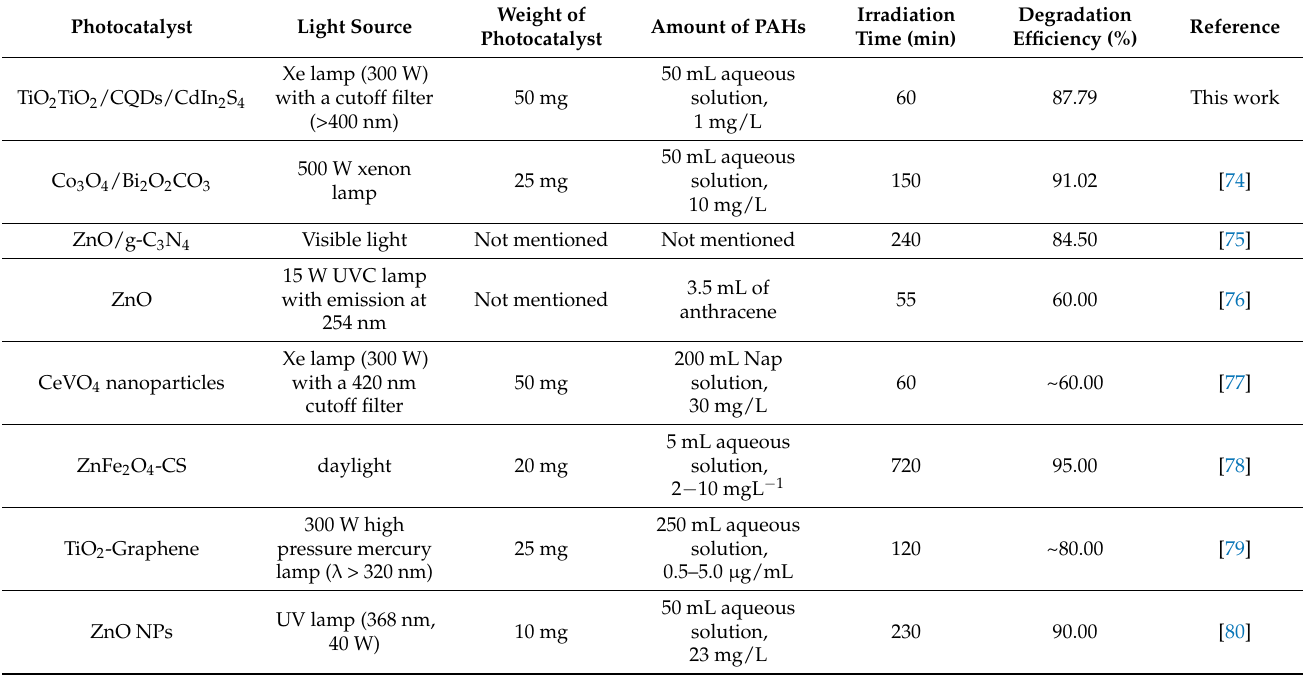
Table 2. Review of photocatalytic degradation performance for PAHs by varies photocatalysts.